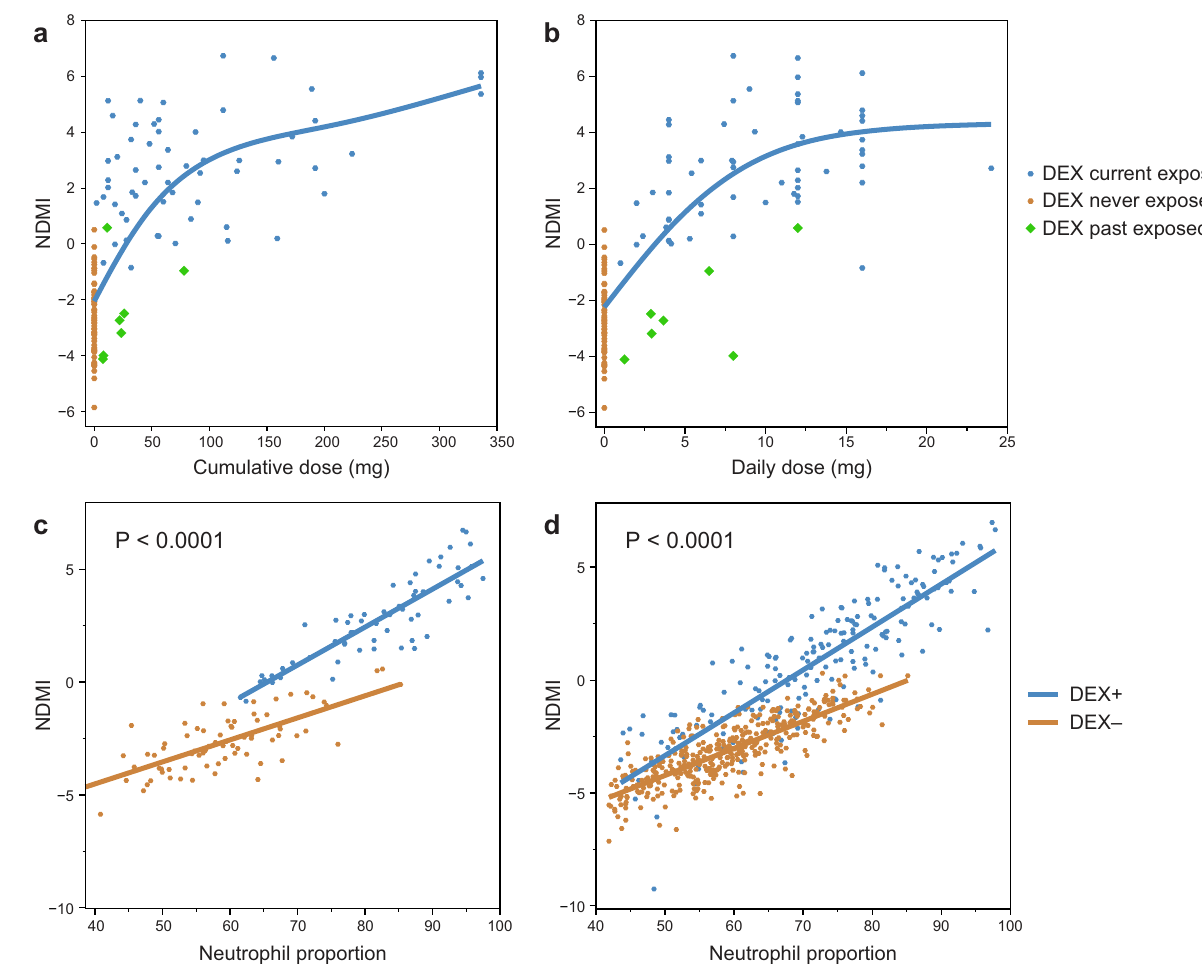
Fig. 4 | Effects of DEX on NDMI response and modi fi cation of NDMI regression on neutrophil proportions. a Dose – response of cumulative mg of DEX versus bloodNDMI scores. b Dose – response of average daily mg DEX versus blood NDMI scores.Smoothcurvesareshown.In a , b ,the7pastexposedsubjectsreceivedDEX 4,7, 8,10,17, 18,and 22days prior to blood draw. c Scatterplot ofNDMI (y-axis)by the predicted relative fraction of neutrophils (x-axis) between 135 DEX+/DEX − subjects (different colored points) in the training dataset. The lines in the plot re fl ect the fi tted regression line for DEX+ and DEX − subjects. The p value resulted